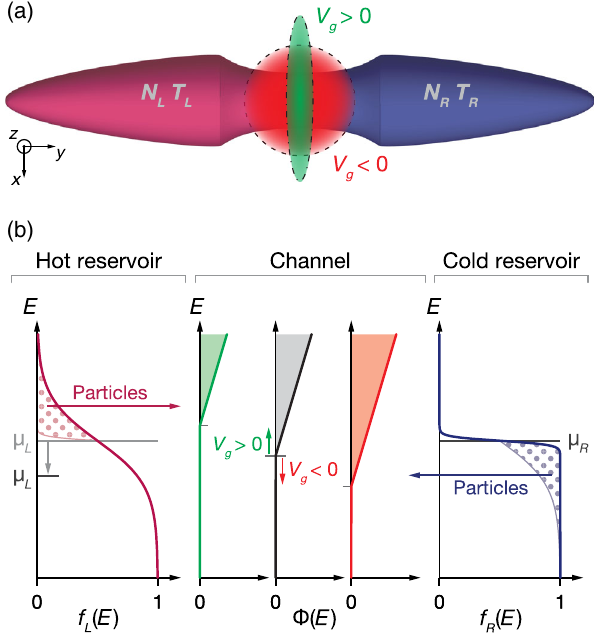
FIG. 1. Concept and experimental setup. (a) Schematic view of a quasi-two-dimensional channel connected to a hot (red) and a cold (blue) reservoir of fermionic atoms. Their unequal temper- atures T and T induce a net particle current that changes the L R initially equal atom numbers N and N over time. The L R thermoelectric response is tuned by a gate potential V inside g the channel that is either attractive (red) or repulsive (green). (b) Roles of the reservoirs and channel in thermoelectric transport. The reservoirs inject particles into the channel according to their E Þ occupations described by the Fermi-Dirac distributions f L ð E Þ . As the hot (cold) side contains more particles at and f R ð high (low) energies compared to the other side (dotted regions), two counterpropagating currents at different energies emerge (horizontal arrows). At equal atom numbers, the chemical potential μ in the hot reservoir is lower than μ on the cold L R side, introducing an asymmetry between them. A particle at energy E crosses the channel in one of the Φ ð E Þ transverse modes. The energy dependence of their number (shaded regions) in- troduces an asymmetry in the channel. The gate potential > 0 ) or down ( V < 0 ), energetically shifts the modes up ( V g g allowing us to tune the response. The picture is valid for weak interactions, as it also applies to Landau